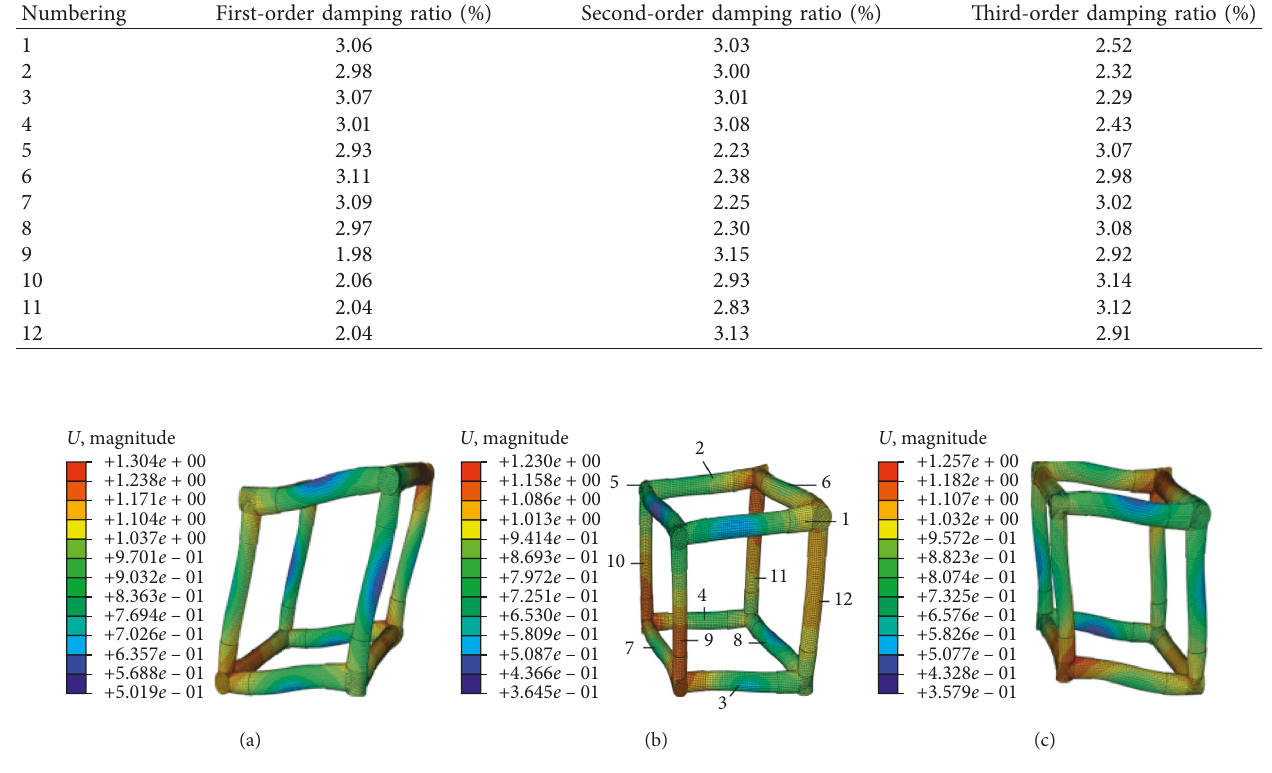
Figure 3: Modal shapes of the (a) first order, (b) second order, and (c) third order of CFRP truss subelements.